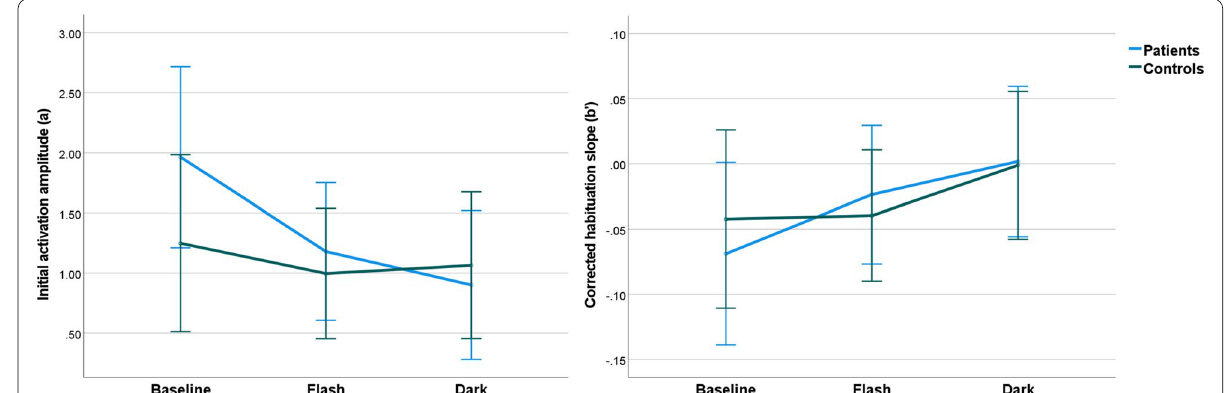
Fig. 4 Initial activation amplitude ( a ) and corrected habituation slope ( b’ ) in the patients and controls for the baseline, Flash and Dark intervention. Patients exhibited a significantly higher initial activation amplitude at baseline compared to Flash and Dark